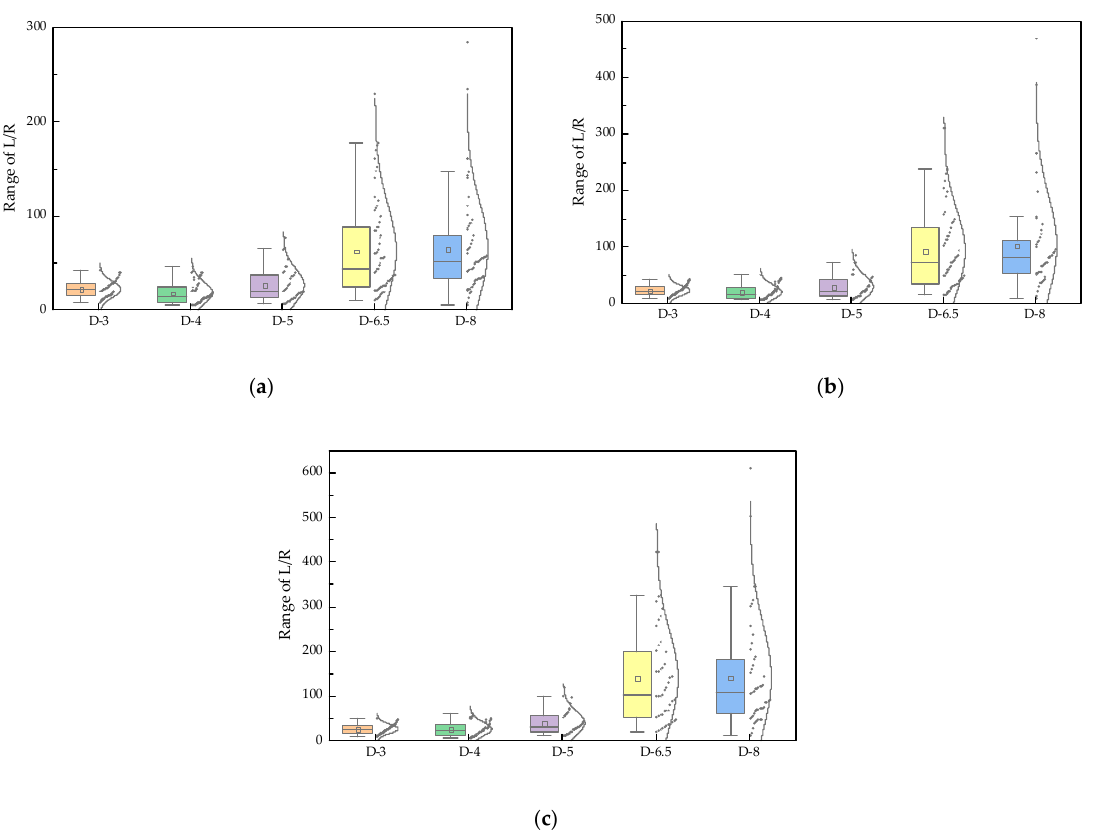
Figure 11. Distribution of bubble lengths in the horizontal section of a long-distance siphon drain: ( a ) low Ca flow; ( b ) early stationary phase; ( c ) late stationary phase. The main hydrodynamic characteristic behaviors of gas-liquid two-phase flow orig- inate from viscous forces, inertial forces, interfacial forces, and gravity. When the scale range changes, the effects of the different forces become entirely different. While gravity plays a significant role in defining the flow characteristics at conventional sizes, it tends to be negligible at the millimeter/micron scale, and interfacial forces play a more promi- nent role. Using the Eötvös number, it is possible to set a boundary criterion between these two scales [21,22]. By definition, it can be used to quantify the equilibrium relationship between gravity and interfacial forces. This is the hydrodynamic phenomenon reflected by the Eötvös number as the rele- vant characteristic number, and the defined equation is shown below.